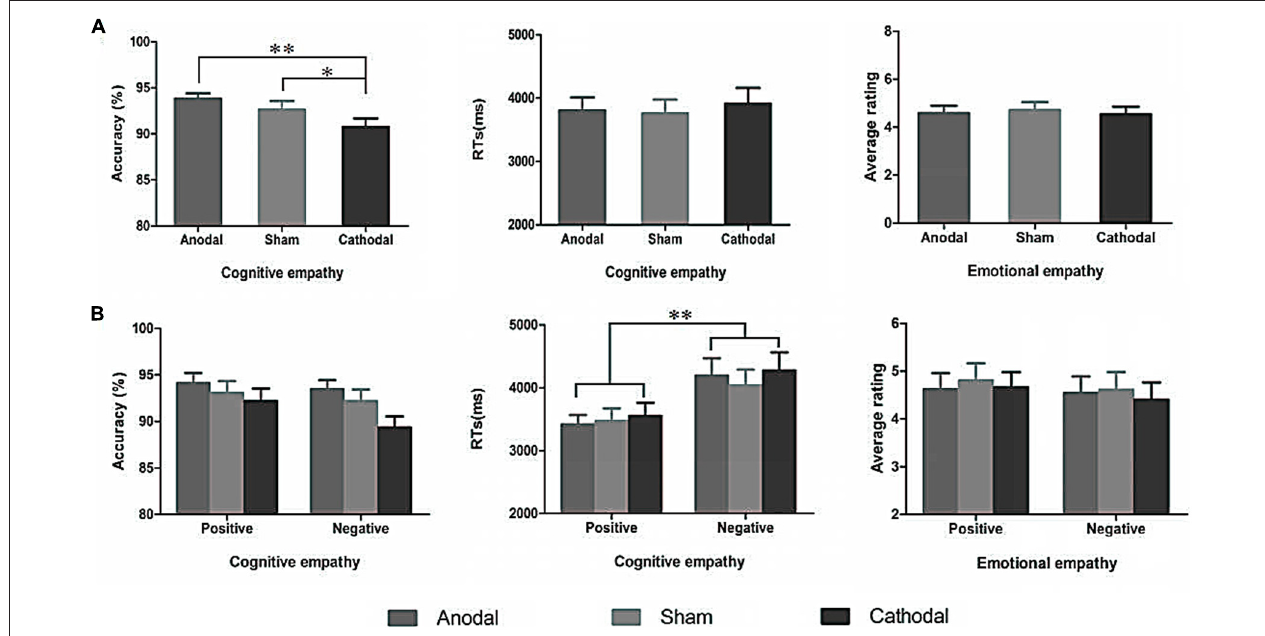
FIGURE 5 | The accuracy and RTs of cognitive empathy, and average ratings of emotional empathy derived from the three stimulation conditions (A) and two valences (B) . Error bars indicate SEM (standard error of the mean) values, ∗ p < 0.05, ∗∗ p < 0.01.